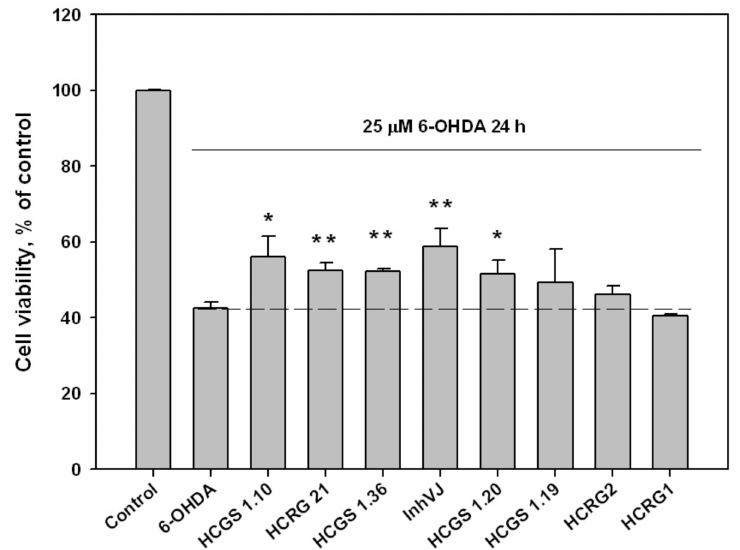
Figure 4. Effects of 10 µ M of Kunitz-type peptides on Neuro-2a cell viability in 6-OHDA-induced neurotoxicity model. Differences between 6-OHDA-treated cells alone (designated by the dotted line) and with peptides preincubated during 1 h are significant with * p < 0.05 and ** p < 0.01. Data were obtained in three independent replicates and calculated values were expressed as mean ± SEM.